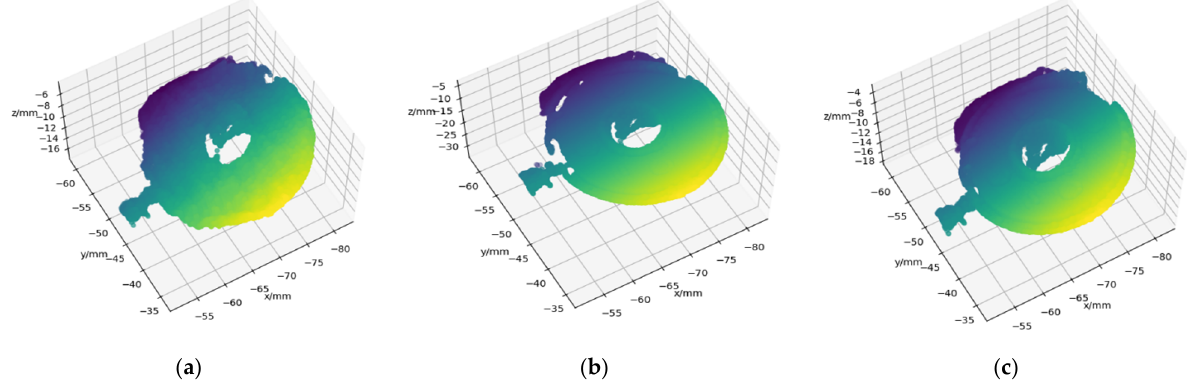
Figure 14. 3D reconstruction results using different single-shot methods: ( a ) result of WFTP [15]; ( b ) result of the FPTNet [20]; ( c ) result of the proposed method.